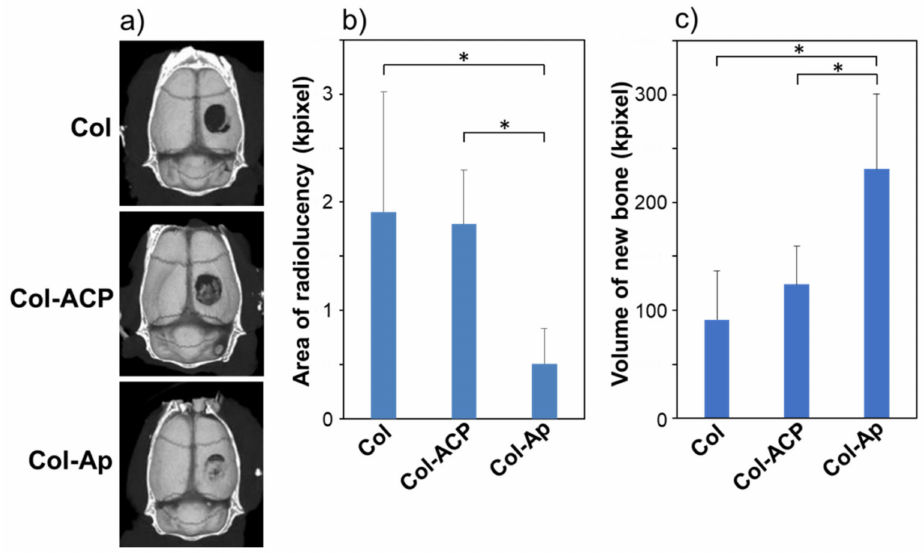
Figure 3. ( a ) Micro-CT images of rat cranial bone two weeks after implantation of Col, Col-ACP, and Col-Ap; ( b ) Radiolucent area (corresponding to the area of the remaining bone defect) and ( c ) volume of new bone from quantitative analyses of the micro-CT images (mean + standard deviation, n = 6, * p <